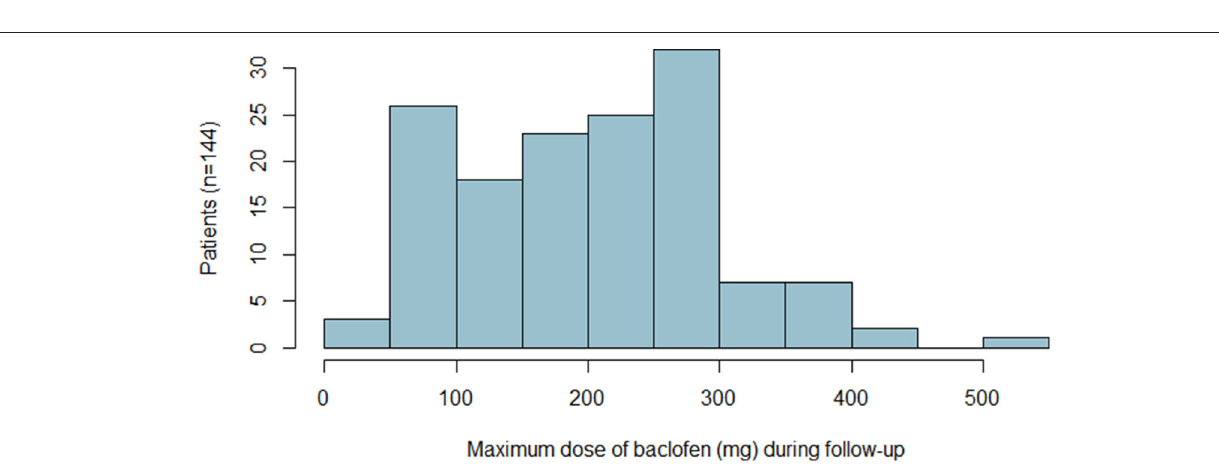
Frontiers in Psychiatry |